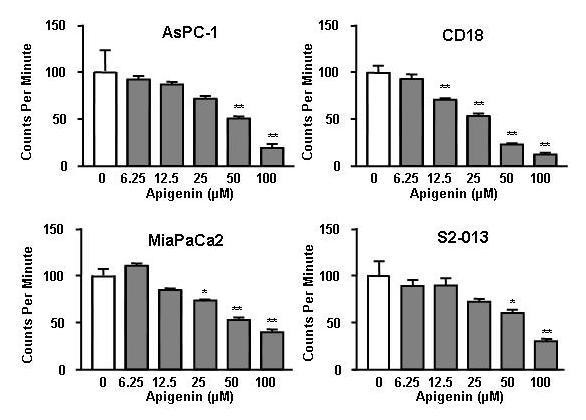
Effects of apigenin on DNA synthesis in human pancreatic cancer cells. Apigenin caused significant concentration-dependent inhibition of DNA synthesis in all four cell lines studied: AsPC-1 [F (5,42) = 10.12, P < 0.0001; P = 0.01 with 50–100 μM]; CD18 [F (5,54) = 38.47, P < 0.0001; P < 0.01 with 12.5–100 μM]; MIA PaCa2 [F (5,72) = 8.698, P < 0.0001; P < 0.05 with 25 μM and P < 0.01 with 50–100 μM]; S2-013 [F (5,72) = 4.099, P < 0.0025; P < 0.05 with 50 μM and P < 0.01 with 100 μM]. Data represent results from at least three separate experiments each performed in triplicate, expressed as a percentage of control.